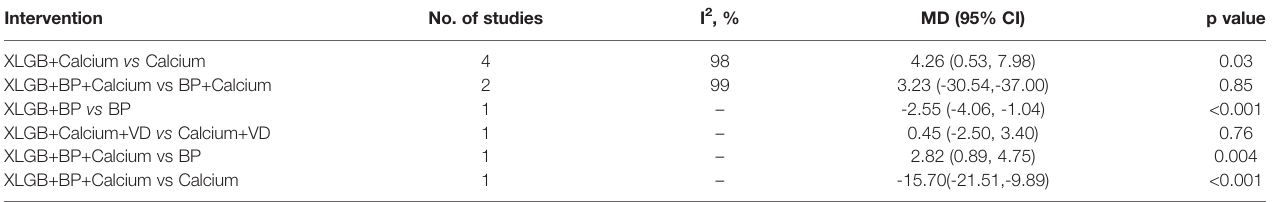
TABLE 4 | Traditional Meta-analysis of BGP.